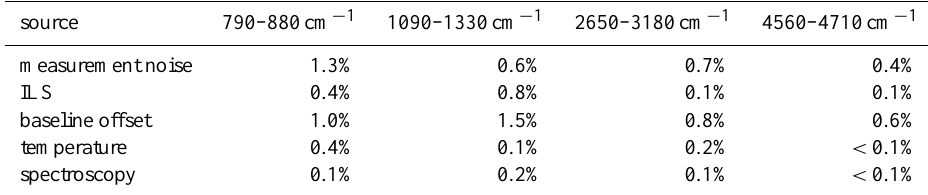
O for retrievals in different spectral regions. 2